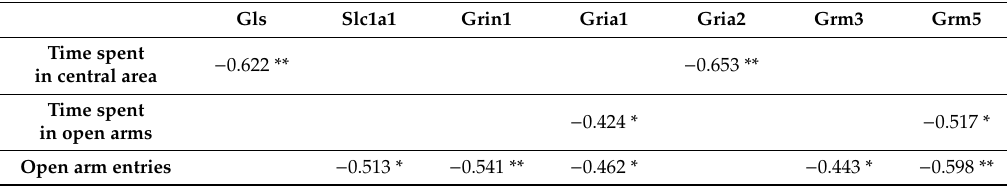
Table 4. Pearson’s correlation coe ffi cients between behavioral parameters related to anxiety and elements of the glutamatergic system. Gls Slc1a1 Grin1 Gria1 Gria2 Grm3 Grm5 Time spent − 0.622 ** − 0.653 ** in central area Time spent − 0.424 * − 0.517 * in open arms Open arm entries − 0.513 * − 0.541 ** − 0.462 * − 0.443 * − 0.598